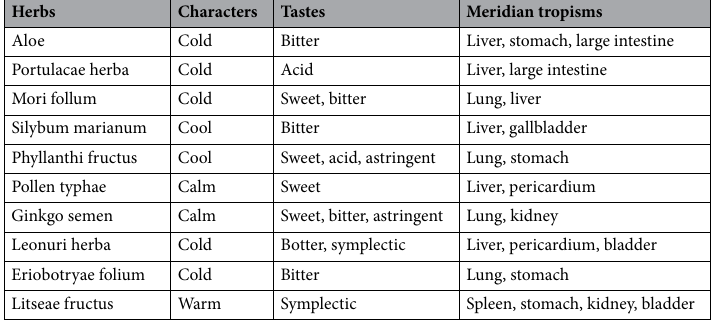
Table 2. The CMPs of key hub